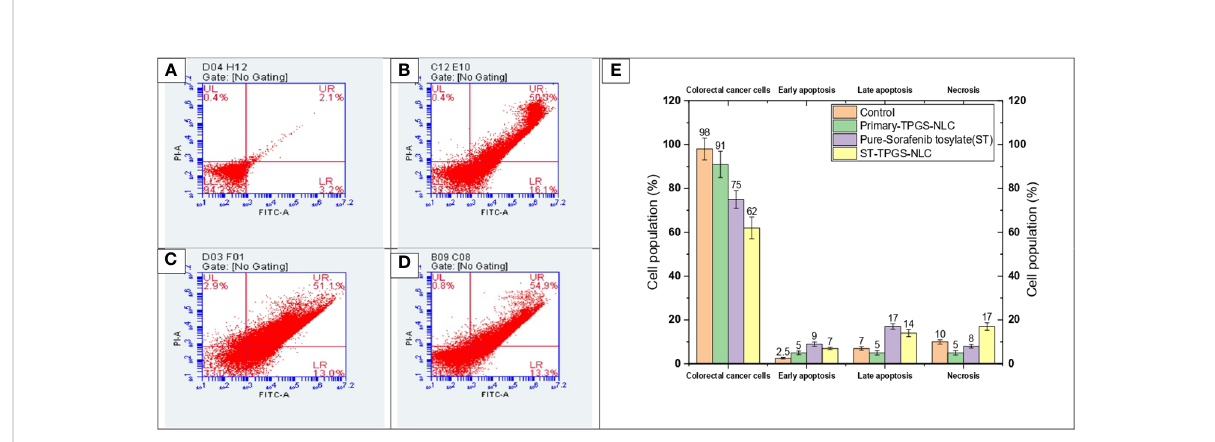
FIGURE 8 Flow cytometric analysis of SW48 Cells PTEN cell line treated with (A) Control, (B) Primary-TPGS-NLC, (C) pure ST, and (D) ST-TPGS-NLC at 12.15 m g/mL concentration. (UL, UR, LR, and LL) Necrotic, late apoptotic, early apoptotic, and viable cells are shown in the upper left quadrant, upper right quadrant, lower right quadrant, and lower left quadrant, respectively. (E) Bar chart shows the percentage of live, early apoptosis, late apoptosis, and necrotic cells that were treated with control, Primary-TPGS-NLCs, Pure-Sorafenib tosylate (ST), and ST-TPGS-SLN. Data were expressed as the mean ± SD, N =